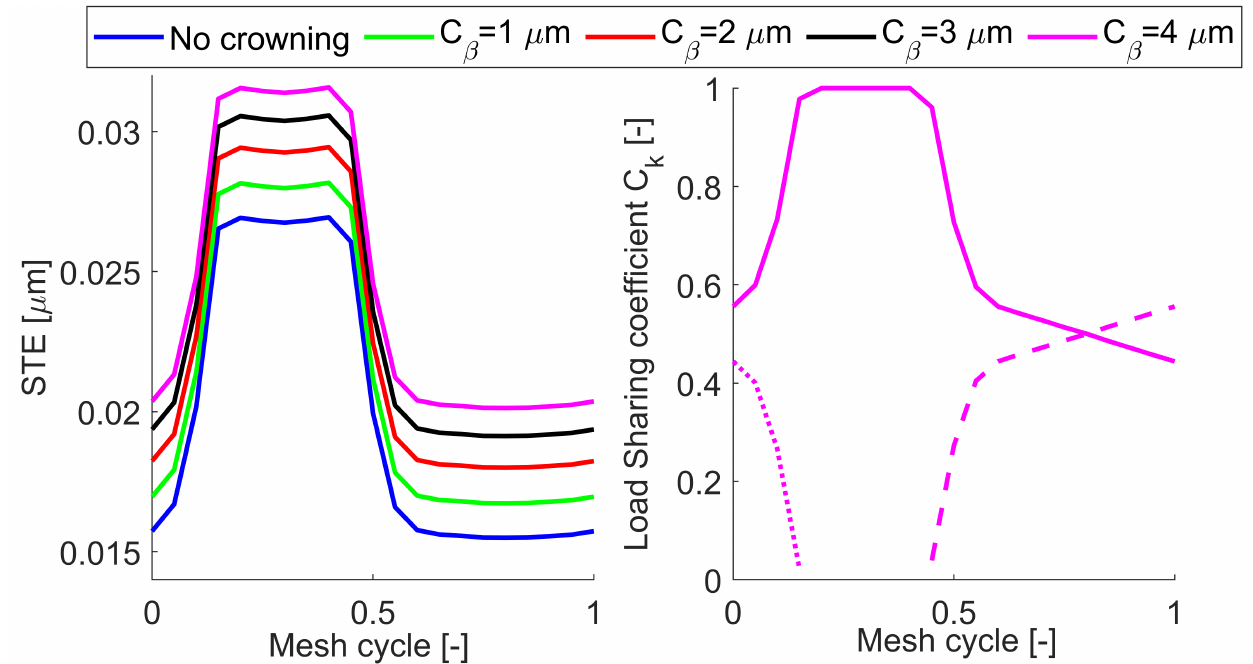
Figure 21. Flank pressure distribution of the tested gear pair with parabolic tip relief, dCa = 94.245 mm and Ca = 32 µ m.